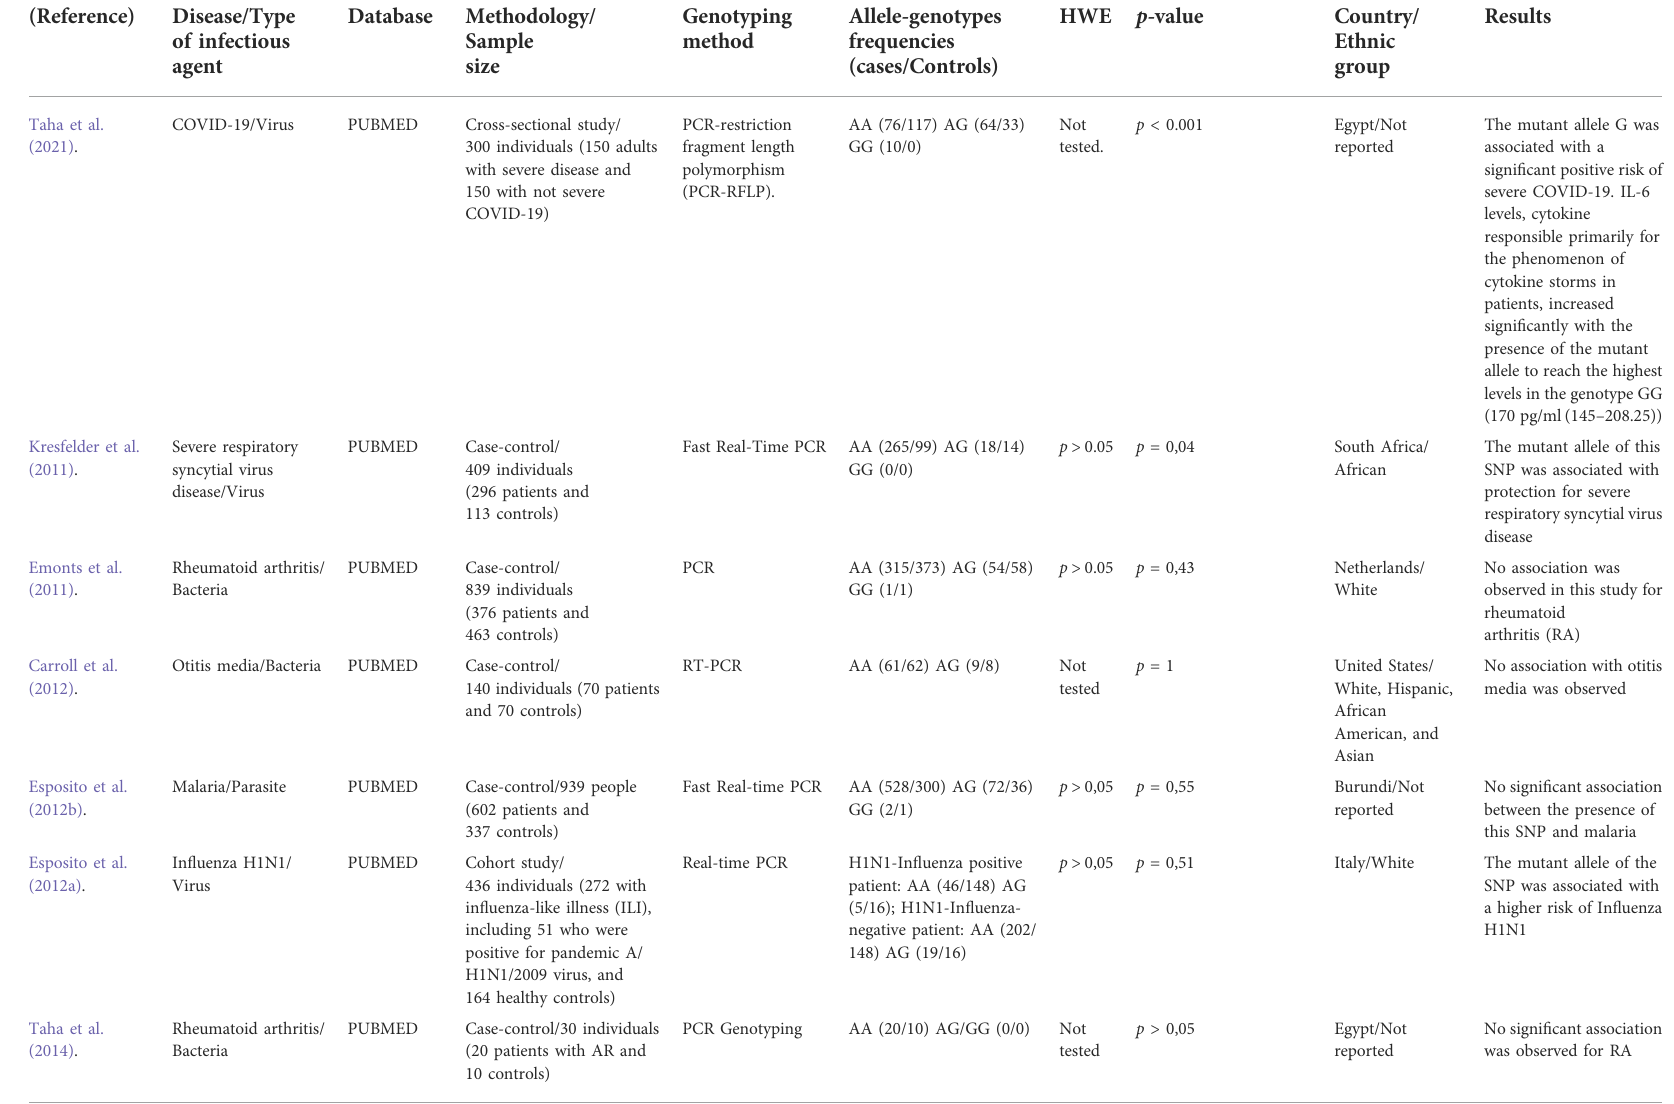
TABLE 1 Characteristics of the studies included in the systematic review.